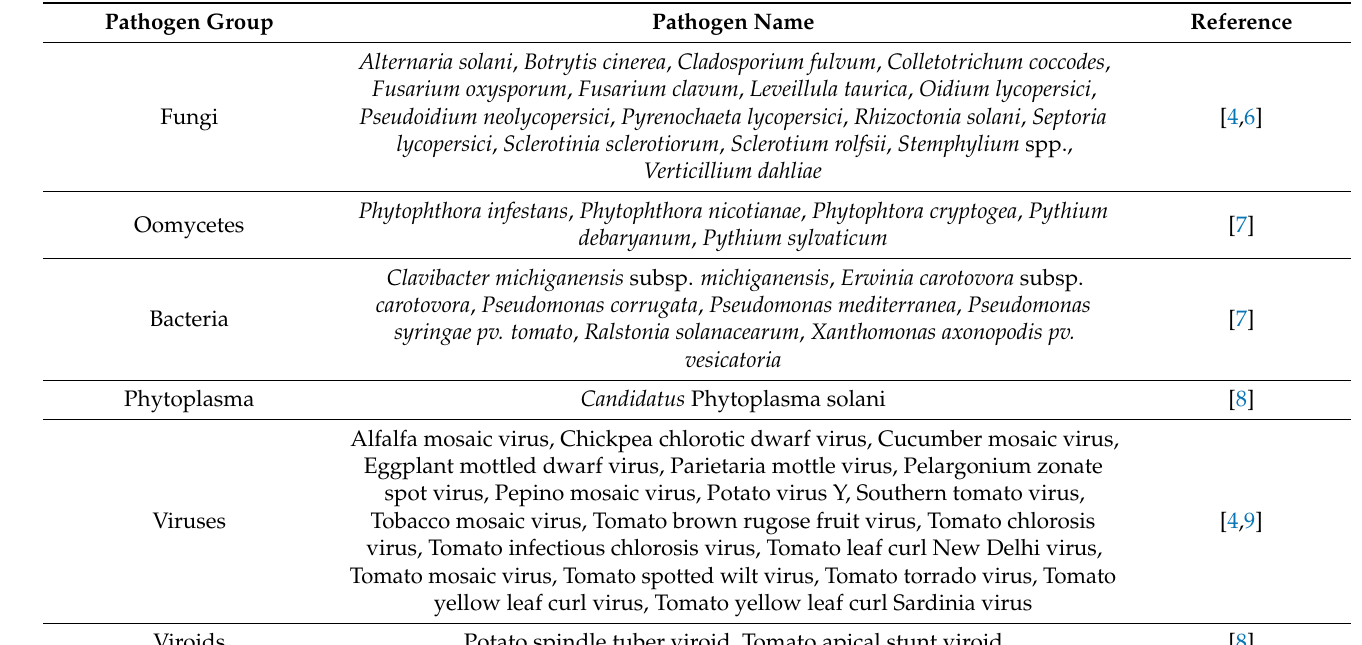
Table 1. List of tomato plant pathogens present in the Mediterranean